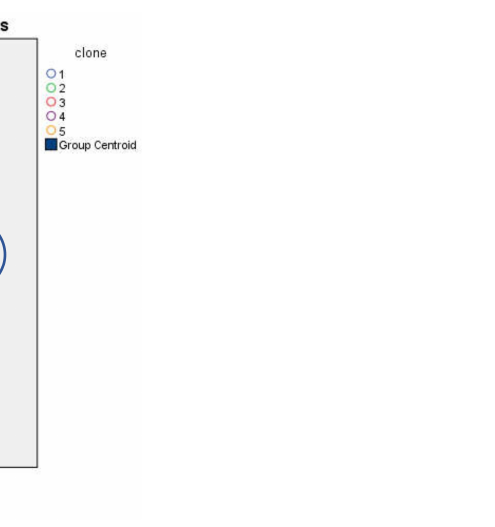
Figure 5. Combined group plot of the discriminant analysis of the black locust clones (Napkor, 2021).